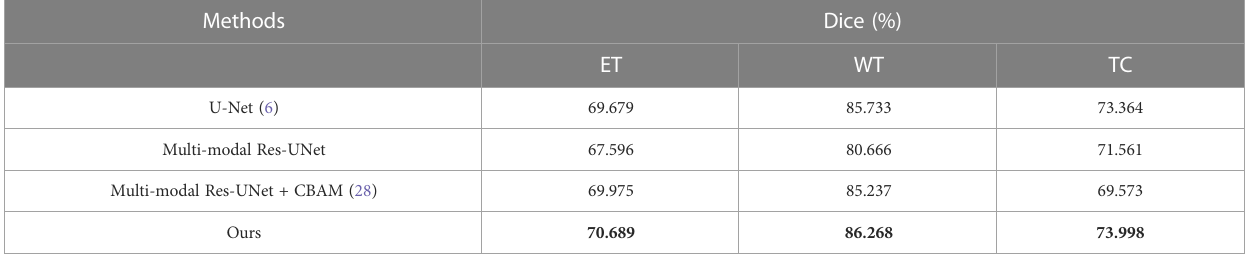
TABLE 1 Comparative experimental results on BraTS